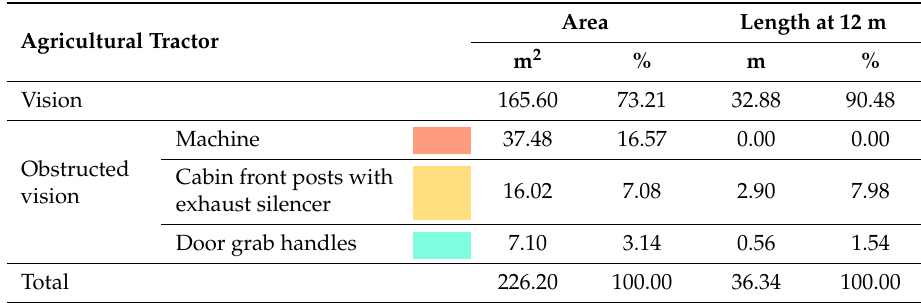
Table 1. Characteristics of the semi-circular vision to the front of agricultural tractor driver determined by the TLS method in units of area and